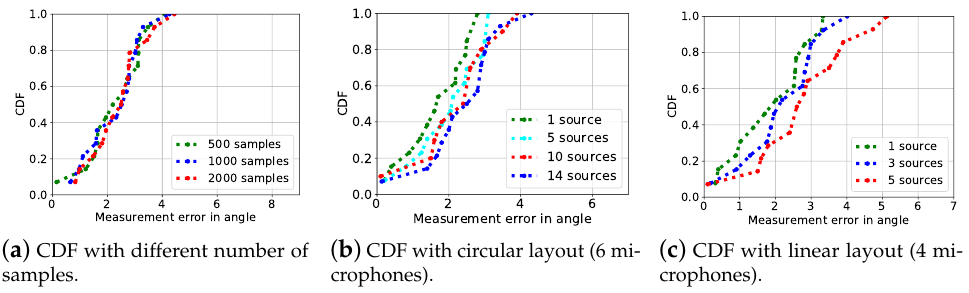
Figure 4. ( a ) depicts the results of source localization under different number of samples, which shows no obvious differences. Source localization errors under different number of sources with circular array ( b ) and linear array ( c